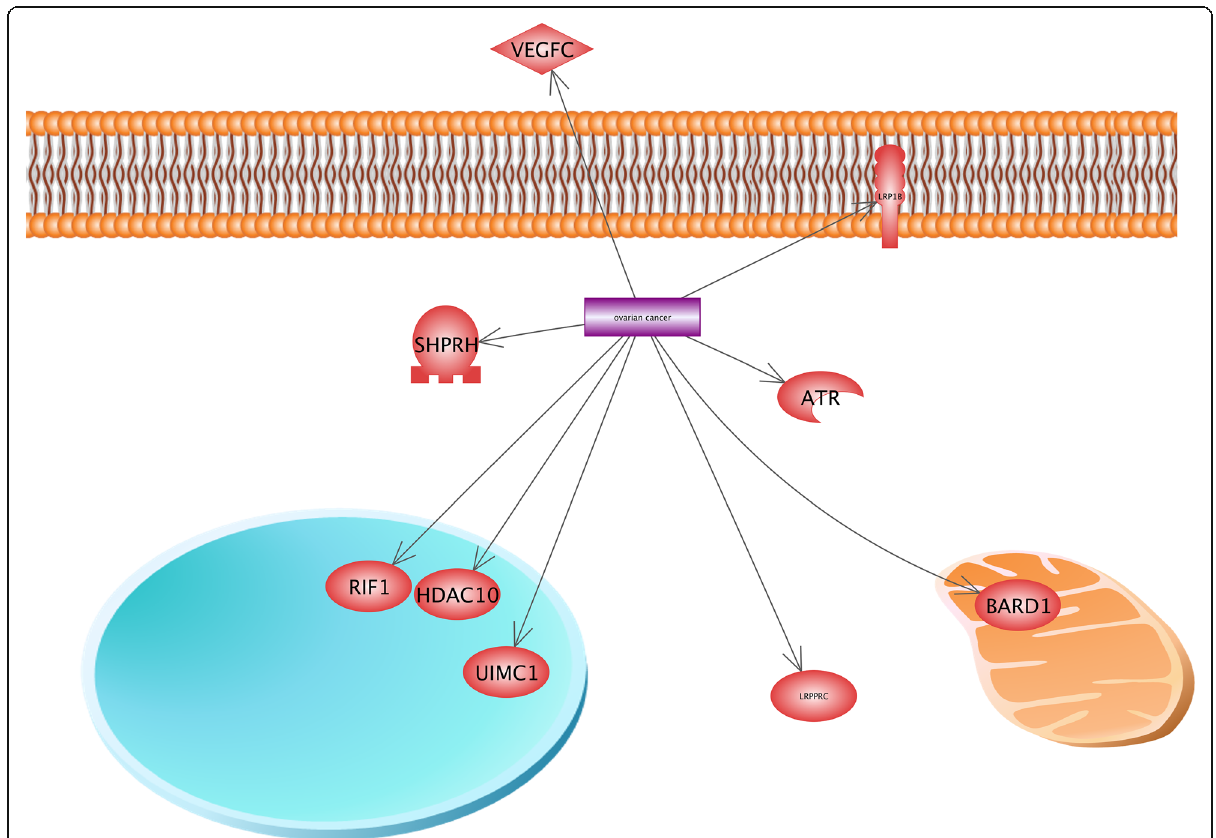
Fig. 9 Gene network construction of hypoxia-associated genes for the description of the ovarian cancer (OC). Results show that VEGF (vascular endothelial growth factor), considered as the protein ligand, is involved in ovarian carcinoma. VEGF enhances cancer cell mobility and promotes the cancer cell metastasis. LRP1B gene encodes low-density lipoprotein receptor-related protein 1B, which plays several important roles in the normal cell function and development due to their interactions with multiple ligands. The disruption of LRP1B is based on several types of cancers and could be considered as the tumor suppressor. Deletion or downregulation of LRP1B is associated with the chemotherapy resistance in